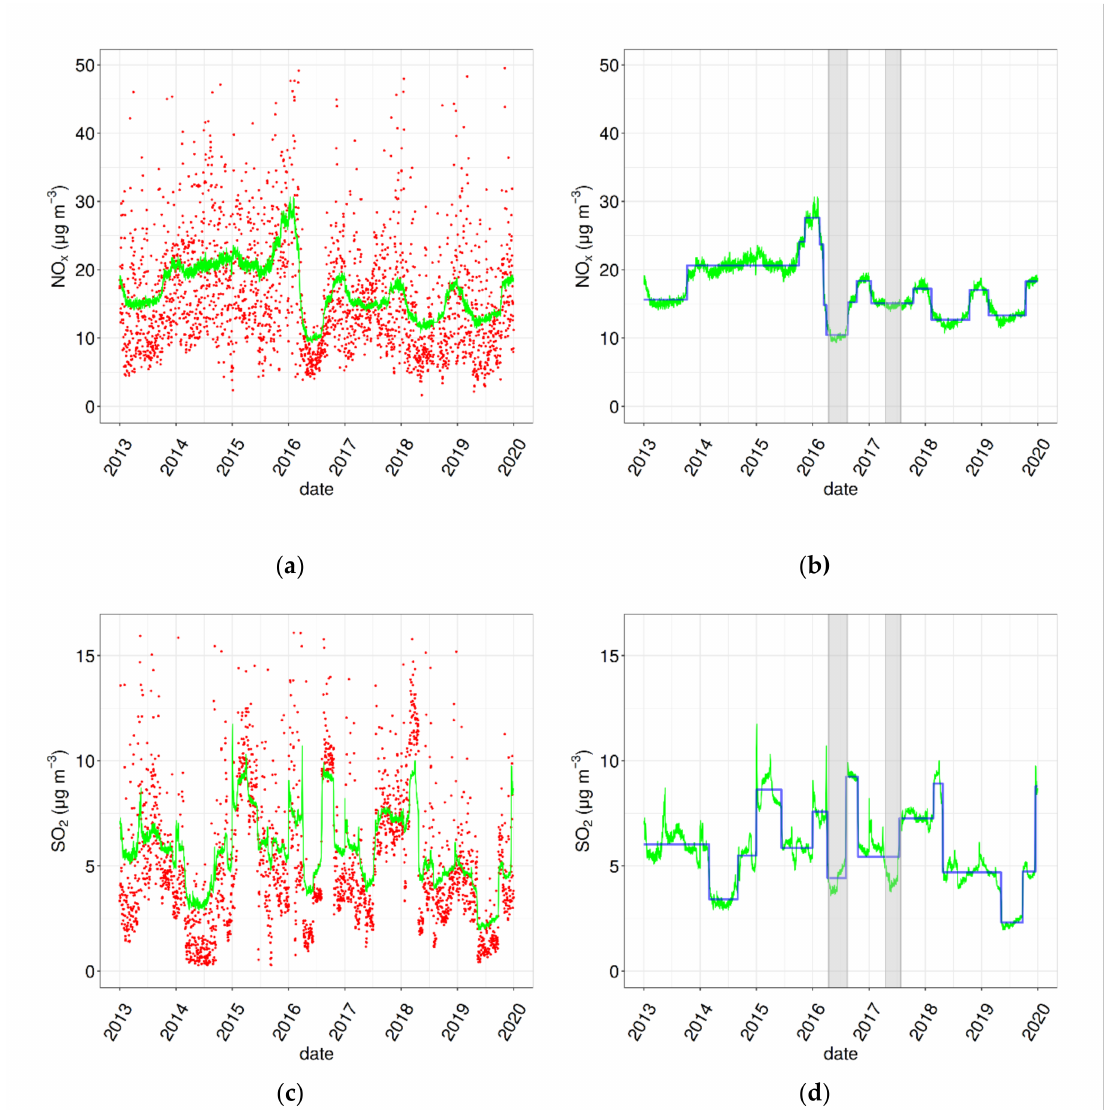
Figure 5. ( a , c ): daily averages of observed ( red dots ) and meteorologically normalized ( green lines ) NOx and SO 2 concentrations. ( b , d ) the wbs change points ( blue lines ) and the periods of COVA plant shutdowns ( grey areas